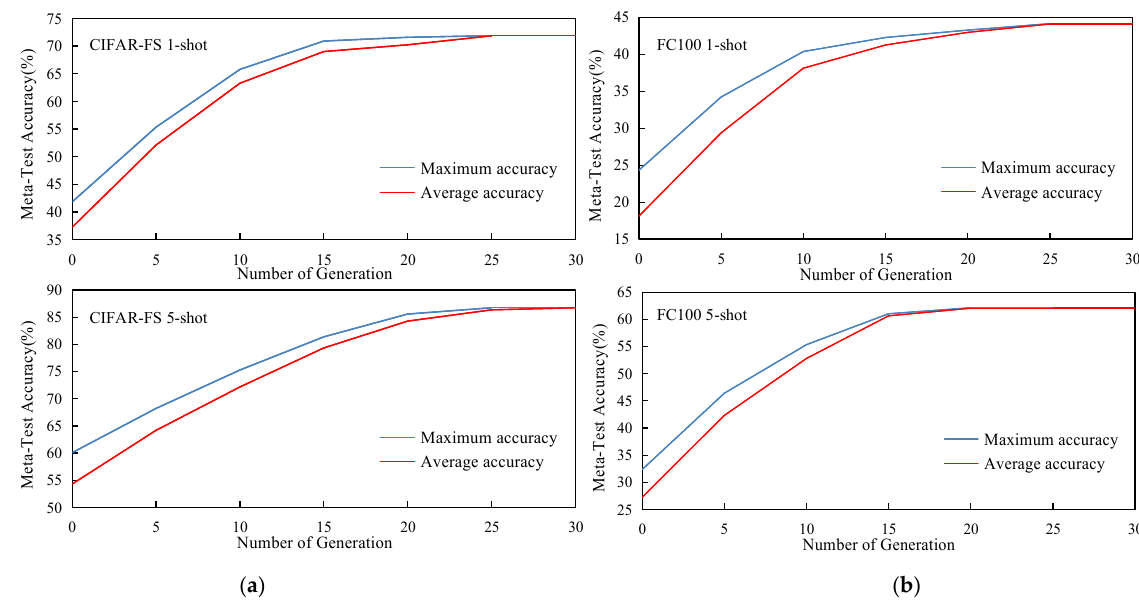
Figure 8. The relationship between the accuracy and the generation in meta-testing on CIFAR-FS and FC100. ( a ) represents the relationship between meta-learning accuracy and the generation on CIFAR-FS. ( b ) represents the relationship between meta-learning accuracy and the generation on FC100. The 0-th generation represents the n groups of feature fusion weights randomly generated during population initialization.